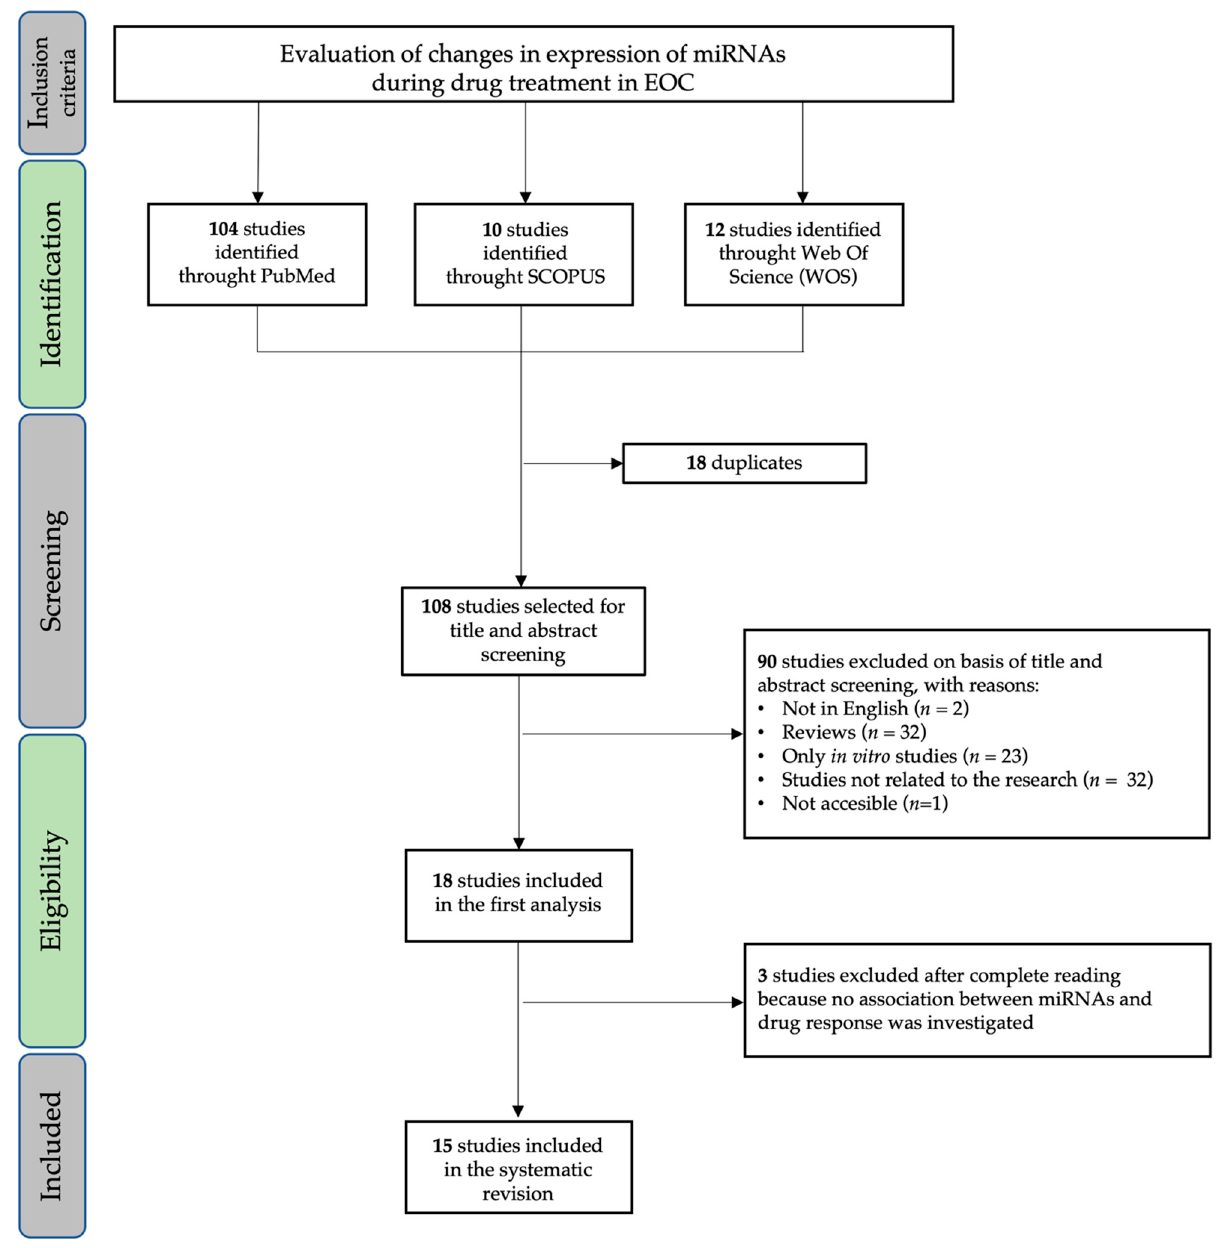
Figure 1. Workflow of the systematic review.